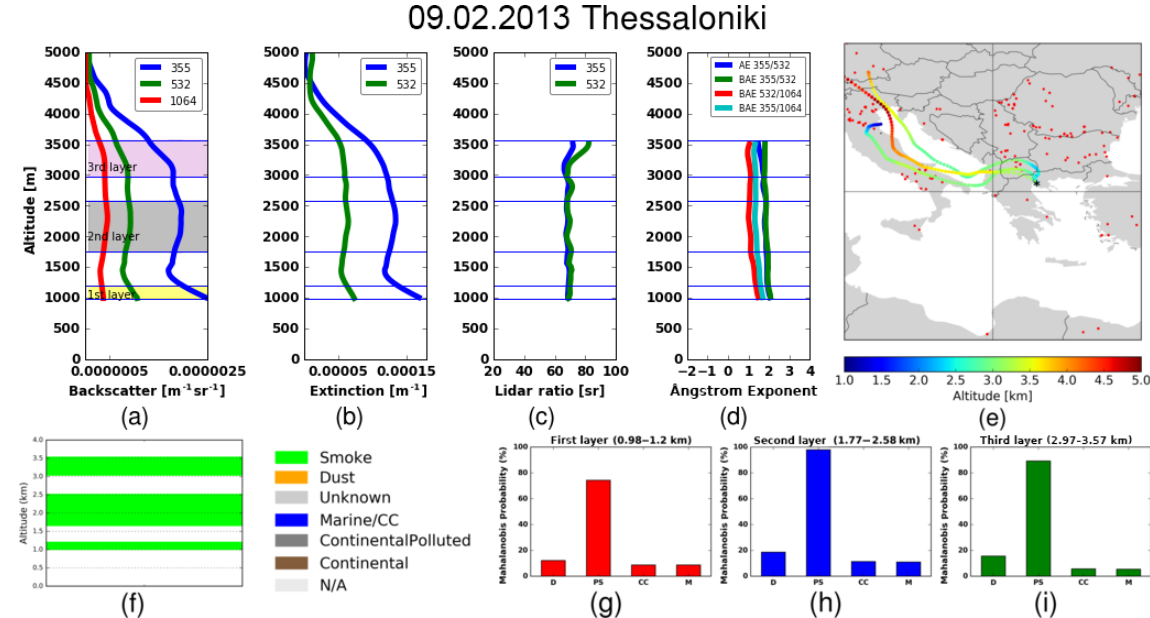
Figure 2. Vertical profiles of aerosol optical properties for Thessaloniki on 2 September 2013. (a) Backscatter coefficient profiles at 355, 532 and 1064nm, (b) extinction coefficient profiles at 387 and 607nm, (c) lidar ratio, (d) Ångström exponent, (e) 3-day backward trajectories arriving at Thessaloniki at each detected layer height, (f) aerosol main layers typed by NATALI, and (g–i) EARLINET Mahalanobis distance- based typing algorithm probability for each detected layer (different from the normalized